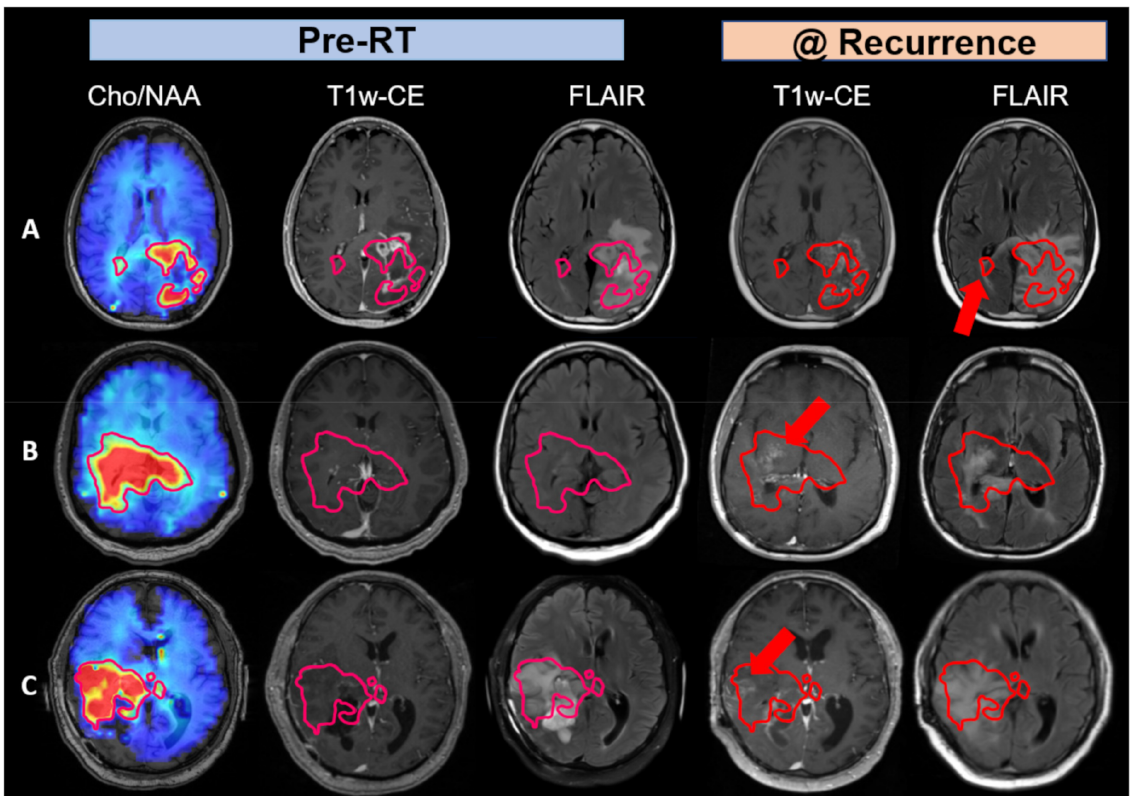
Figure 4. Pre-RT sMRI scans suggest out-of-field recurrence in the belinostat cohort with tumor infiltration beyond what is shown in standard imaging (indicated by red arrows). ( A ) This patient had two-fold Cho/NAA elevation that had spread contralaterally. While pre-RT standard imaging failed to detect this, FLAIR hyperintensity at recurrence mimics the direction of tumor infiltration detected by pre-RT sMRI. ( B ) The second patient had tumor infiltration across the midline that wasn’t detected by pre-RT standard imaging. Lesions at recurrence in both T1w-CE and FLAIR MRIs confirm Cho/NAA abnormalities in the pre-RT sMRI scan, suggesting standard imaging underestimated the extent of tumor infiltration. ( C ) This patient had a large lesion of metabolically active tumor that was not shown in T1w-CE, thus, undertreated, which became apparent at